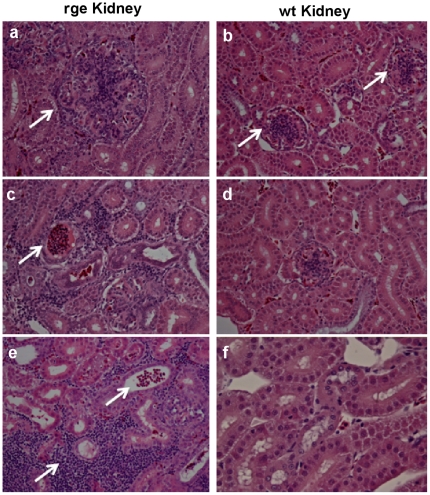
Histopathological findings on kidney sections of rge chickens.Glomeruli from mutant kidneys (Fig. 7a) are considerably larger than their wild type counterparts (Fig. 7b); whereas tubules are of approximately the same diameter. Red blood cells in large numbers are seen in the lumen of tubules and where present are associated with flattening injury to the tubular epithelium (Fig. 7c and d). These red cells are not seen in wild type kidneys (Fig. 7b, d, & f). There is a focus of severe tubulo-interstitial inflammation (lower arrow) comprising lymphocytes and macrophages infiltrating tubules in rge that are not seen in wt kidneys. Magnification 66×.